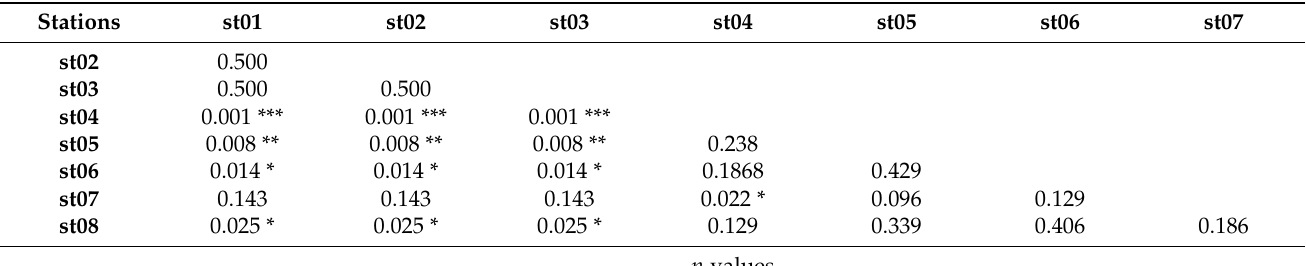
Table 2. Results of the pairwise Dunn test between D. villosus densities in each station. *: statistical significance, **: high statistical significance, ***: very high statistical significance. Stations